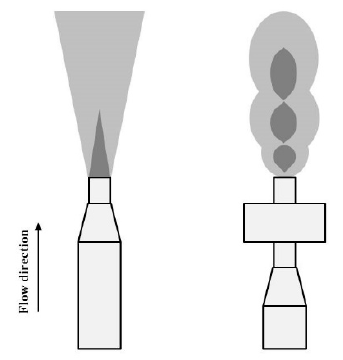
Figure 1. Schematic of a continuous jet ( left ) and a pulsed jet ( right ).